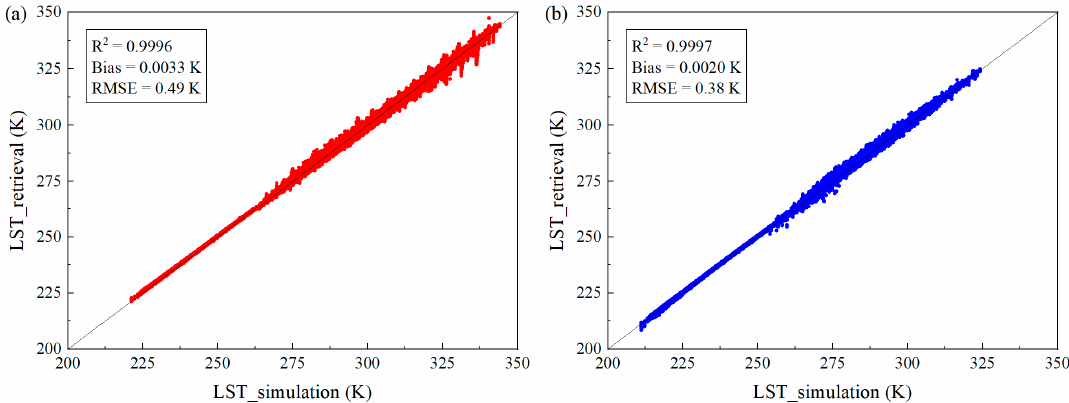
Figure 6. Algorithm test results for ( a ) daytime algorithm and ( b ) nighttime algorithm.